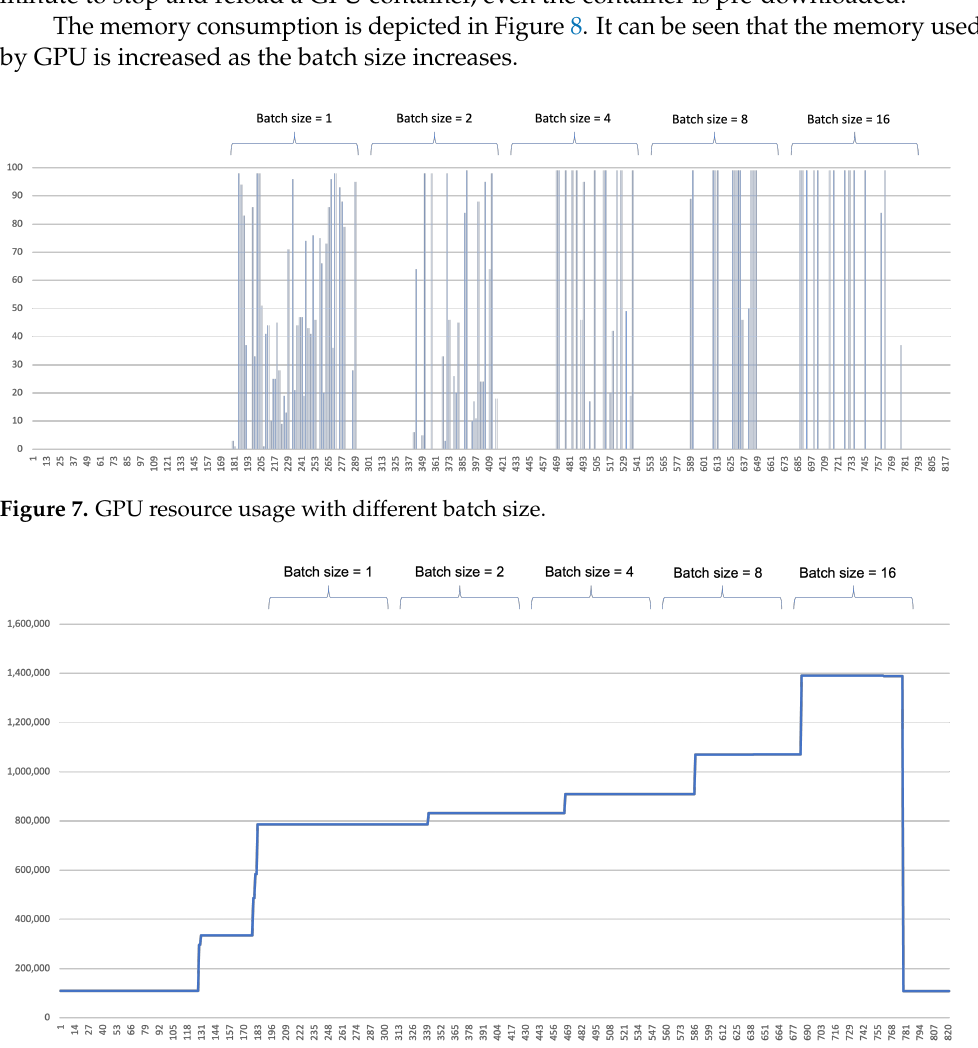
Figure 8. Memory consumption of GPU with different batch